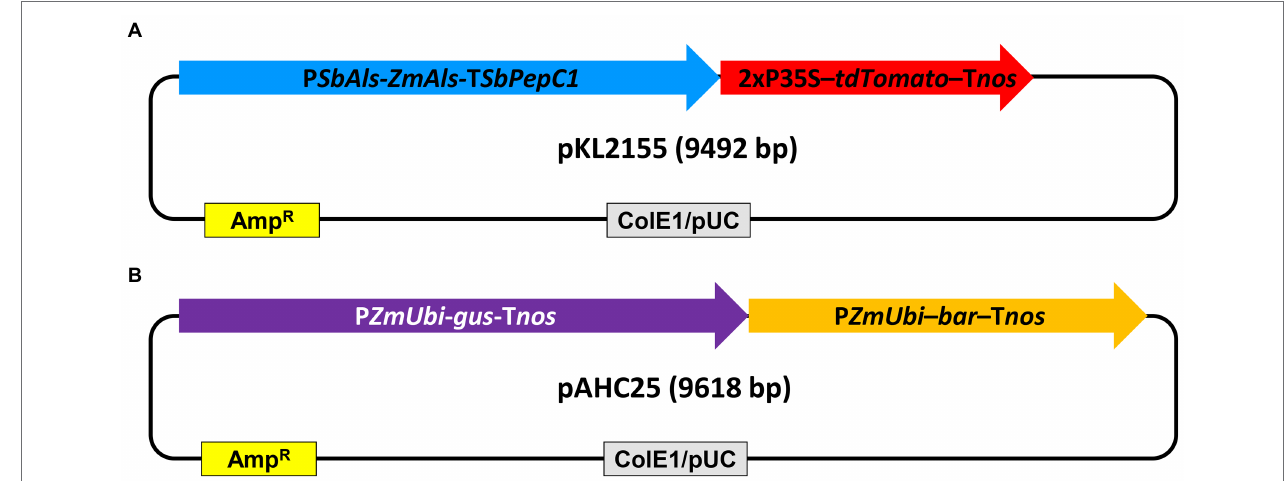
FIGURE 2 | Schematic illustration of the plasmid DNA constructs used for teosinte transformation. (A) pKL2155, 9,492 bp. P SbAls - Als -T SbPepC1 , the sorghum acetolactate synthase gene promoter driving the mutant acetolactate synthase gene with sorghum PepC1 gene terminator; 2xP35S- tdTomato -T nos , 2x CaMV 35S promoter driving tdTomato with Agrobacterium nopaline synthase gene ( nos ) terminator; (B) pAHC25 (Christensen and Quail, 1996), 9,618 bp. P ZmUbi - gus -T nos , maize ubiquitin gene promoter (P ZmUbi ) driving β -glucuronidase gene with the nos terminator; P ZmUbi - bar -T nos , P ZmUbi driving bialaphos resistance bar gene with the nos terminator; ColE1/pUC, high copy number origin of replication from Escherichia coli ; Amp R , ampicillin resistance β -lactamase gene